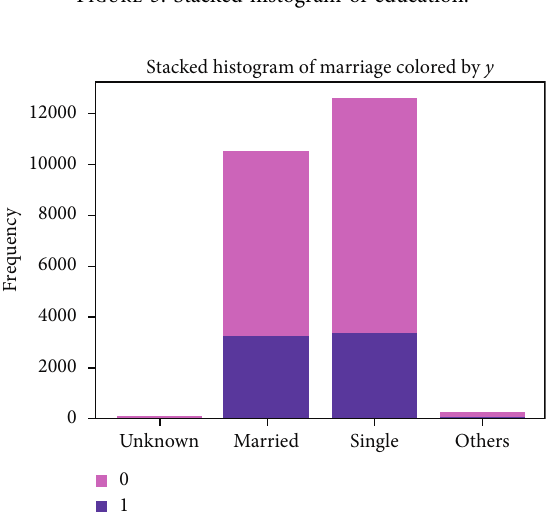
Figure 5: Stacked histogram of education.